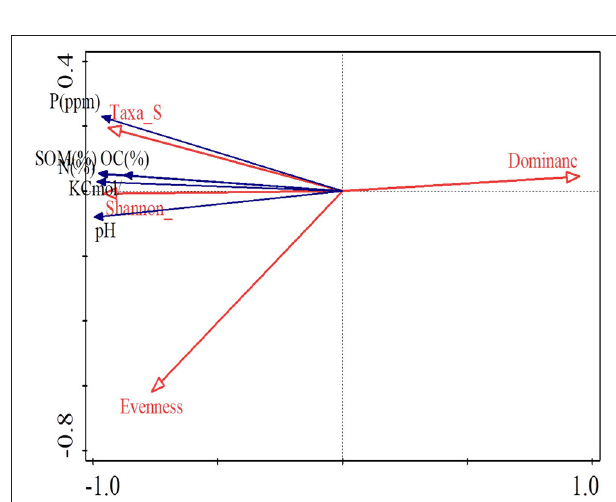
FIGURE 3 | Redundancy analysis showing the relationship between the soil characteristics and nodule isolate